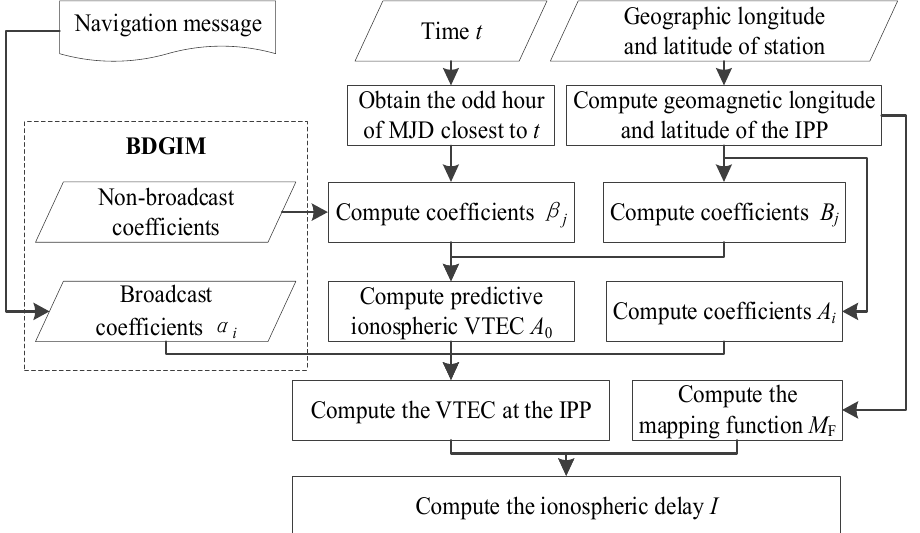
computing the ionospheric delay with the BDGIM.